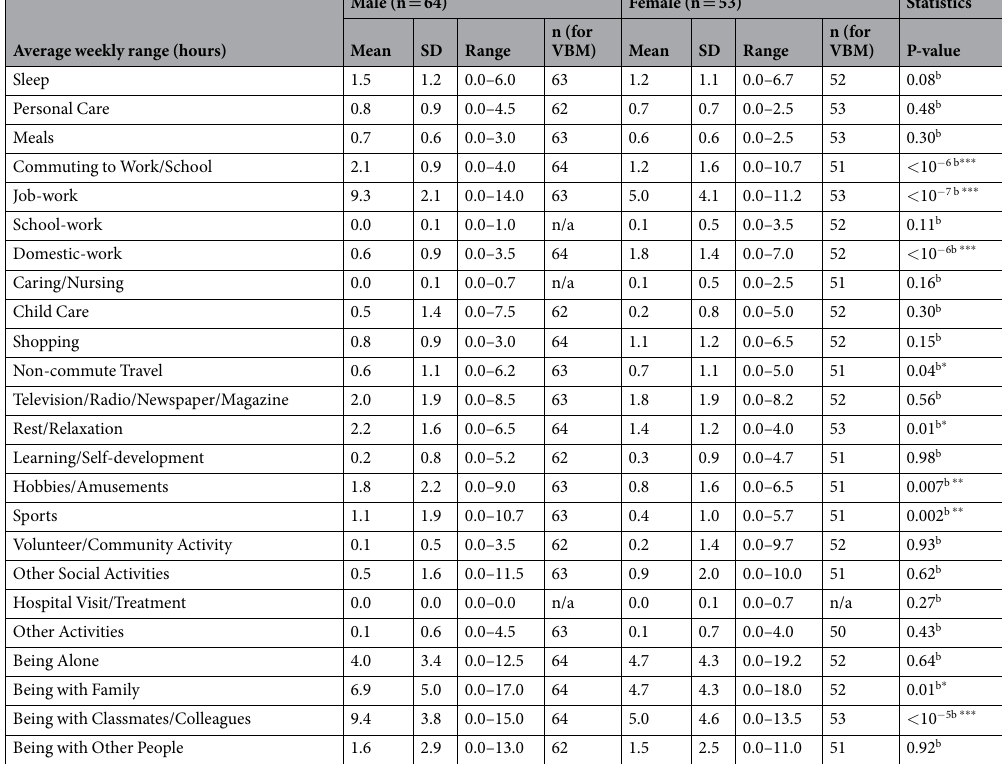
Table 3. Average weekly range of activity. * p < 0.05, ** p < 0.01, *** p < 0.001, a t-test, b Mann-Whitney U test, n/a: not